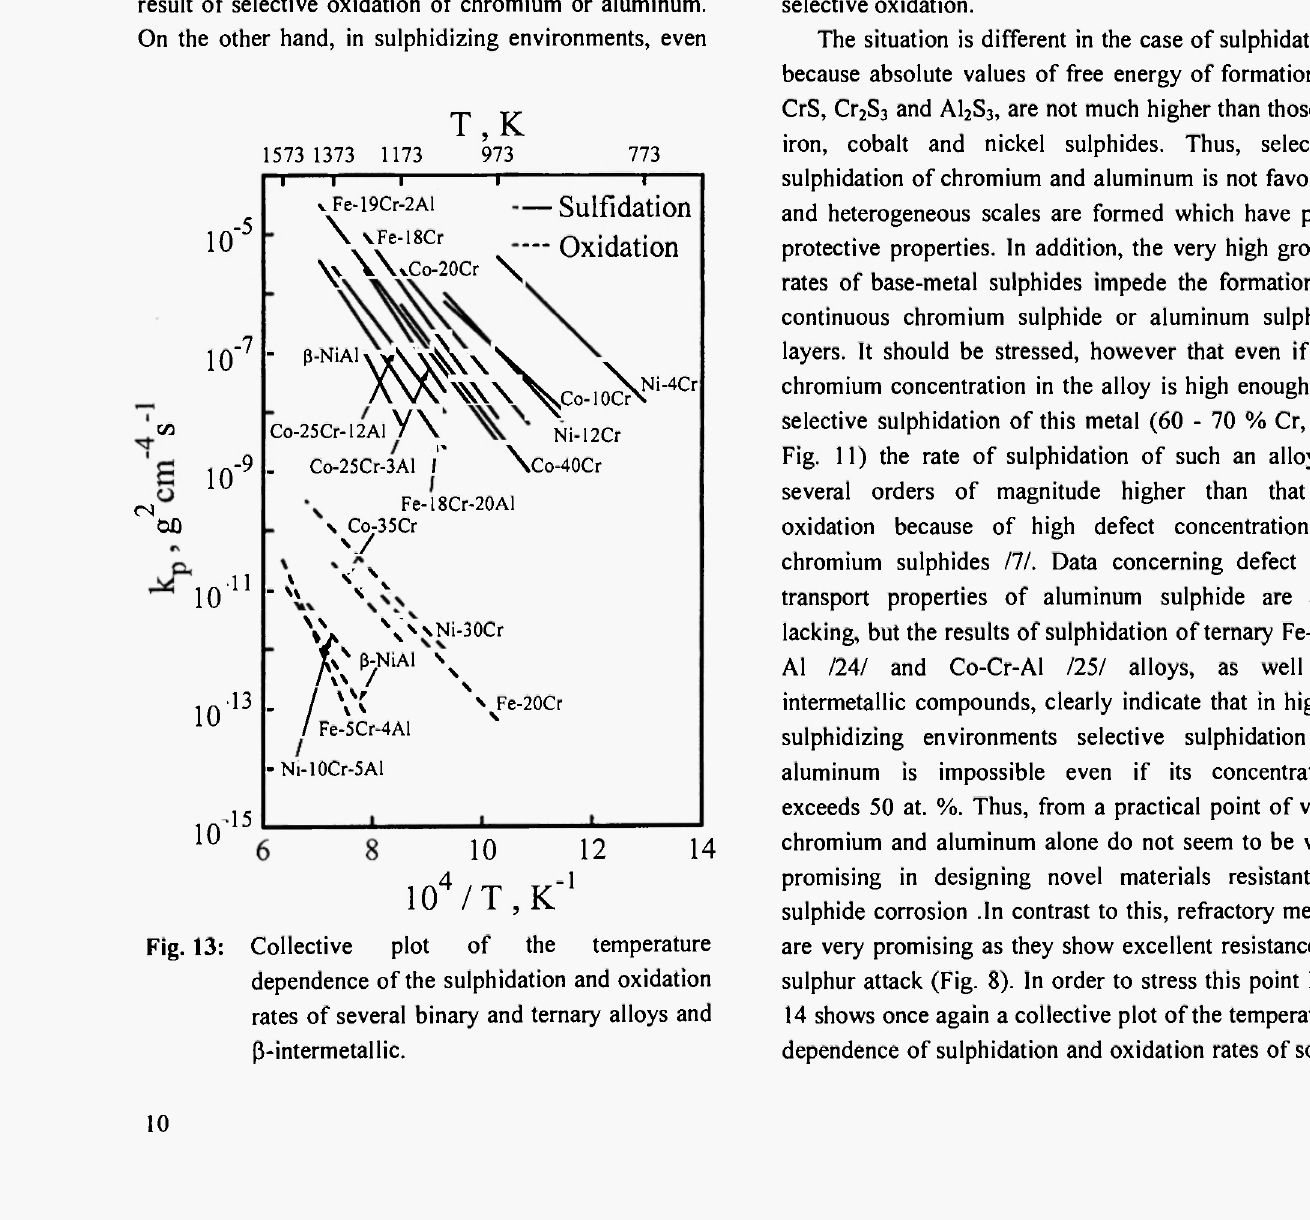
Fig. 13: Collective plot of the temperature dependence of the sulphidation and oxidation rates of several binary and ternary alloys and